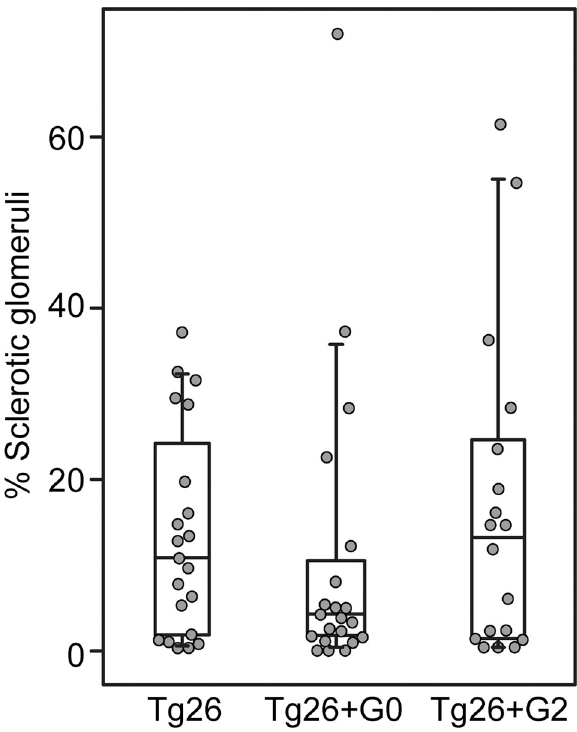
Fig 1. APOL1-G0 reduced glomerulosclerosis in a murine model of HIVAN. Box whisker plot of total sclerotic glomeruli (aggregate global and sclerotic glomeruli from Table 1) as a percentage of total scored glomeruli per animal. Each data point represents one mouse, boxes are interquartile range, whiskers are 95% confidence intervals. Numbers in each group were Tg26 n = 21, Tg26+G0 n = 21, Tg26+G2 n = 18.